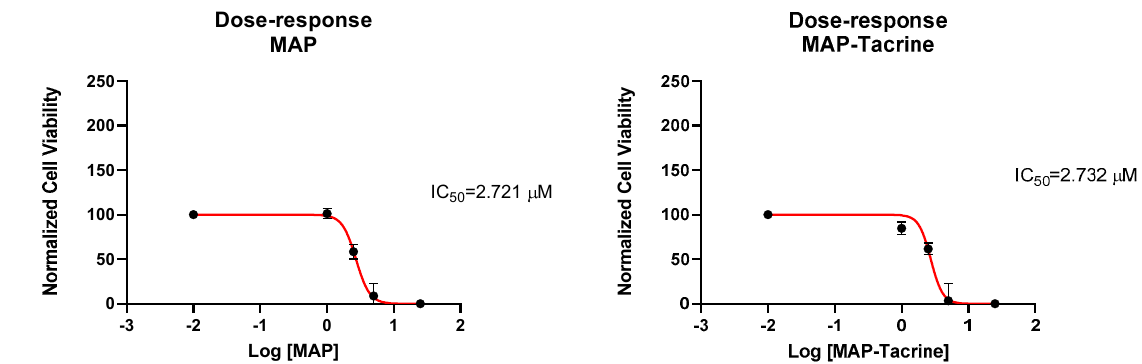
Figure 6. Dose-response curves (from triplicates) of MCF-7 cells viability with increasing concentrations (1, 2.5, 5, 10, 20, and 25 µ M) of MAP (left plot) and MAP-Tacrine (right plot). IC50 values thus determined are shown next to the respective curves. The values represent mean ± SEM ( n = 3).